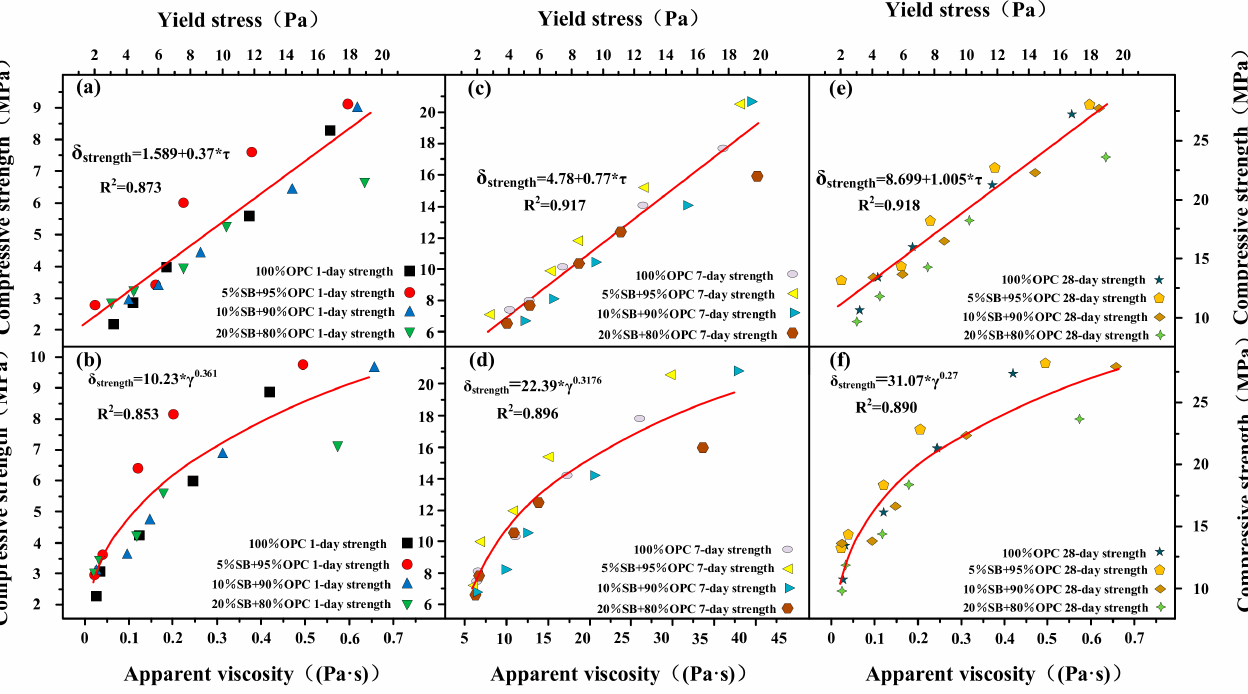
Figure 12. Apparent viscosity and yield stress versus 1 day ( a , b ), 7 days ( c , d ), and 28 days ( e , f ) of compressive